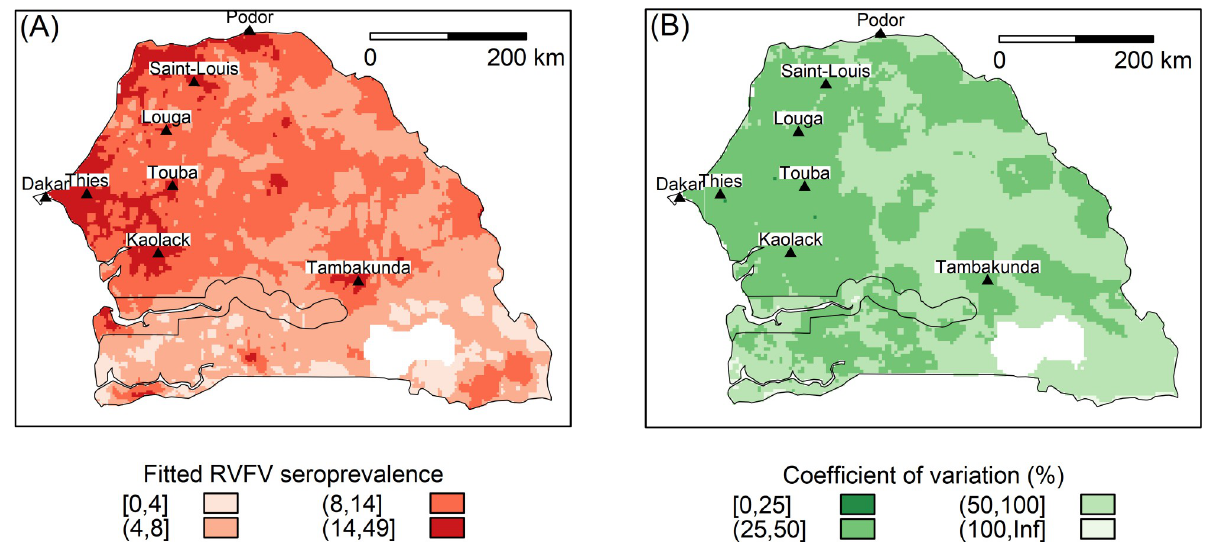
Fig 5. RVFV seroprevalence in small ruminants after the 2013–2014 RVF outbreak in Senegal (A) and its coefficient of variation (B) fitted by the DIC-best spatial beta-binomial logistic regression model (primary source of the map: